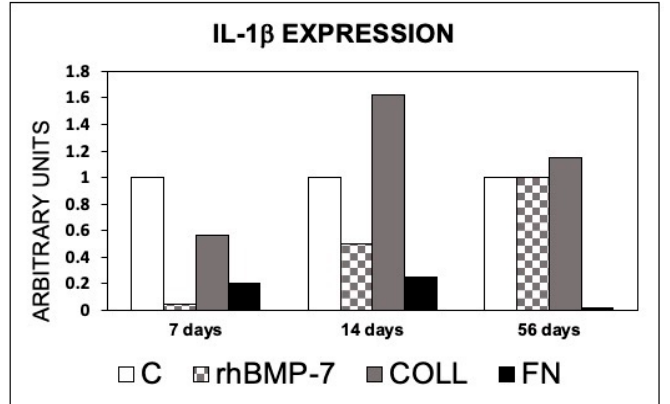
Figure 10. Expression of IL-1 β in peri-implant bone tissues from sites treated with rhBMP-7, Type 1 Collagen, or Fbronectin. The values are expressed as a ratio on control sites taken as 1. C, control sites; rhBMP-7, sites treated with rhBMP-7; COLL, sites treated with Type 1 Collagen; FN, sites treated with Fibronectin.